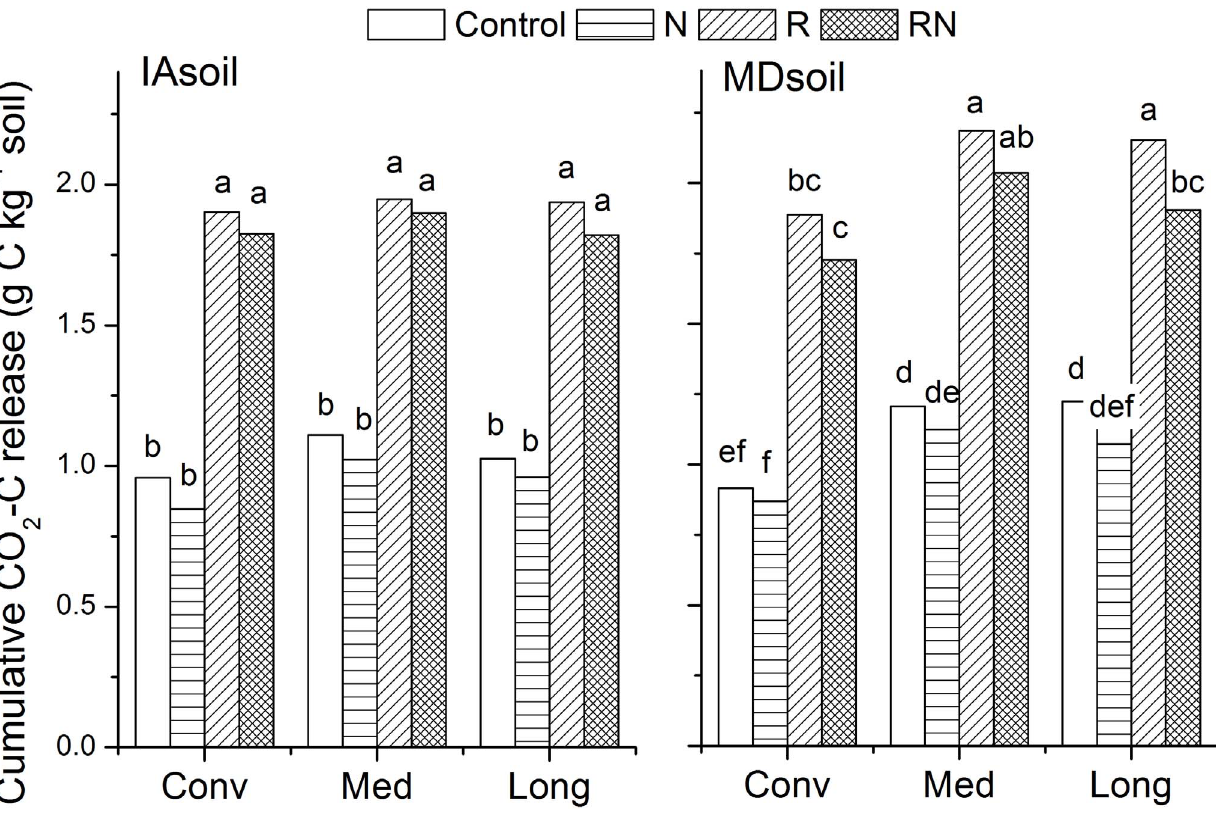
Figure 1. Cumulative CO 2 -C release from the IAsoil and the MDsoil after 330 days incubation. Control: treatments with no residue or N fertilizer added. N: treatments with N fertilization. R: treatments with residue application. RN: treatments applied with both residue and N fertilizer. Different letters above bars suggest significant differences at p , 0.05, comparisons were made for the interaction of cropping system (Conv, Med, Long) by treatments (Control, N, R, RN) within each site (IAsoil, MDsoil).